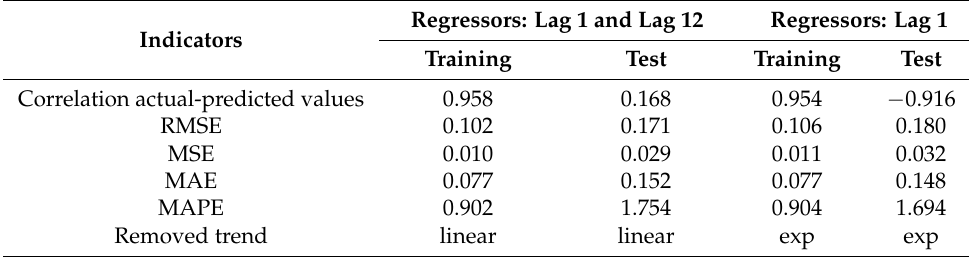
Table 9. Performances of the best models built for